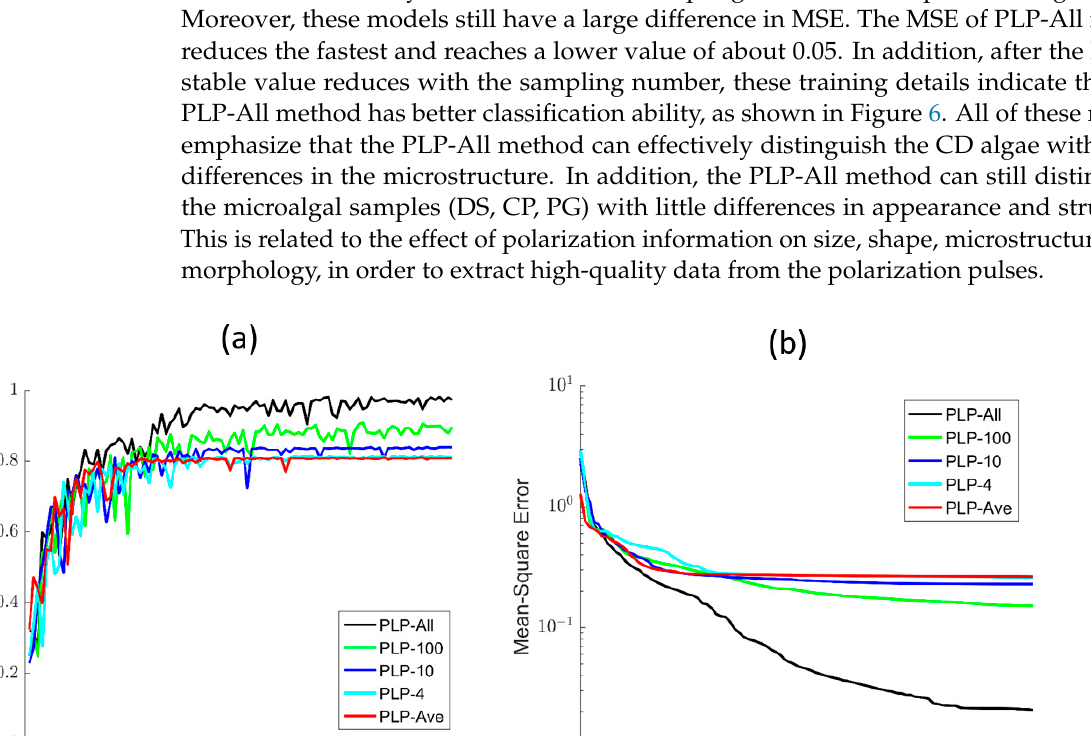
10 of 15 Table 3. Accuracy of PLP-Ave model and PLP-All model. Dataset Training Set Test Set PLP-Ave model